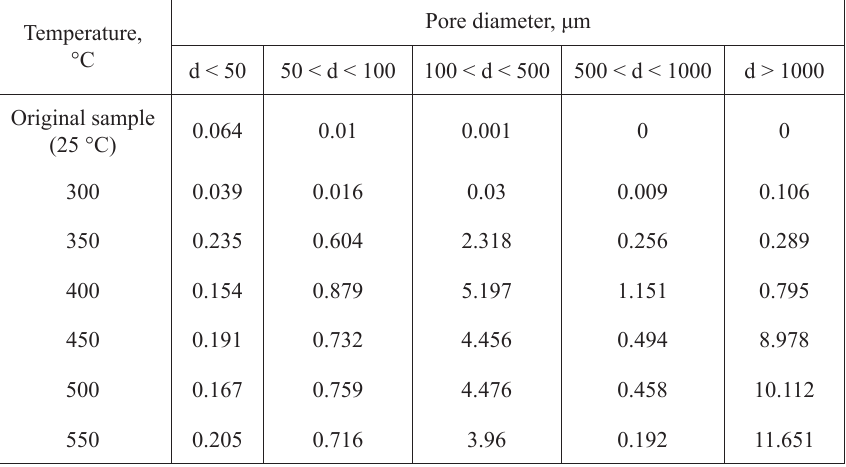
Table. 2. Volume percentage of pores with different diameters in digital cores, %